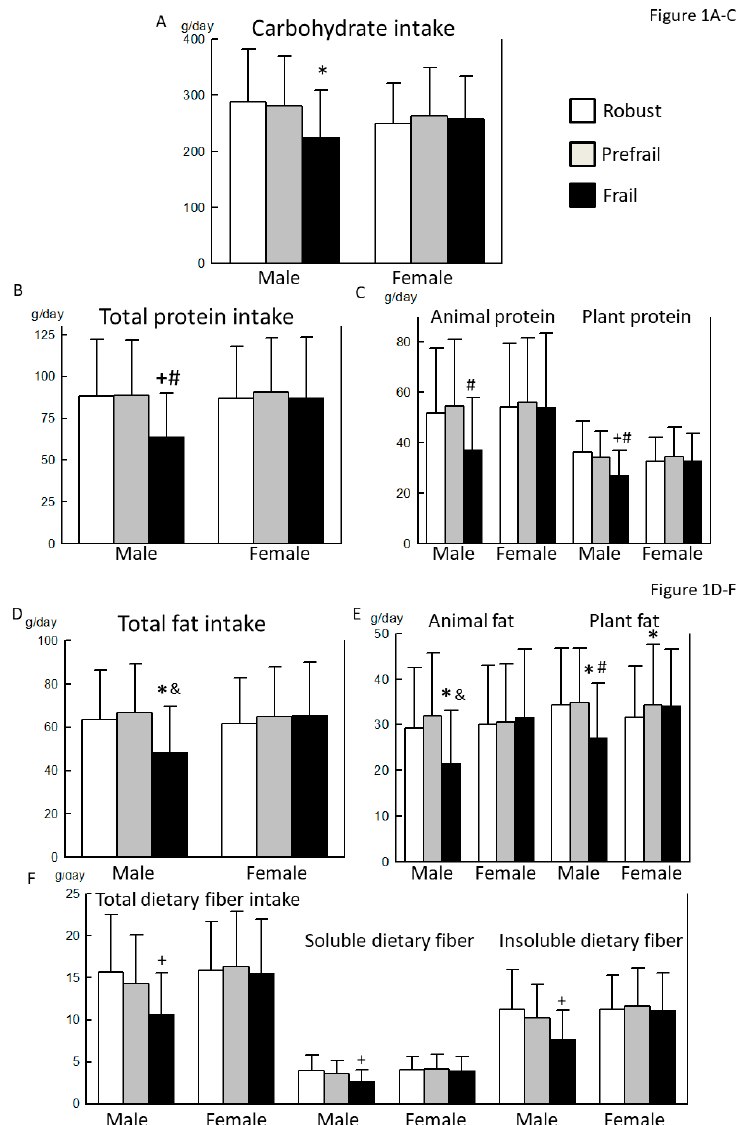
Figure 1. Comparison of macronutrient intake between robust, prefrail, and frail individuals, diagnosed by the Kihon checklist. ( A ): Carbohydrate intake, ( B ): Total protein intake, ( C ): Animal and plant protein intake, ( D ): Total fat intake, ( E ): Animal and plant fat intake, and ( F ): Total, soluble, and insoluble dietary fiber intake. ∗ : p < 0.05 vs. Robust, +: p < 0.01 vs. Robust, #: p < 0.05 vs. Prefrail, &: p < 0.01 vs. Prefrail. Table 3. Basic characteristics and dietary habits among frail, prefrail, and robust women, as diagnosed by the KCL criteria.